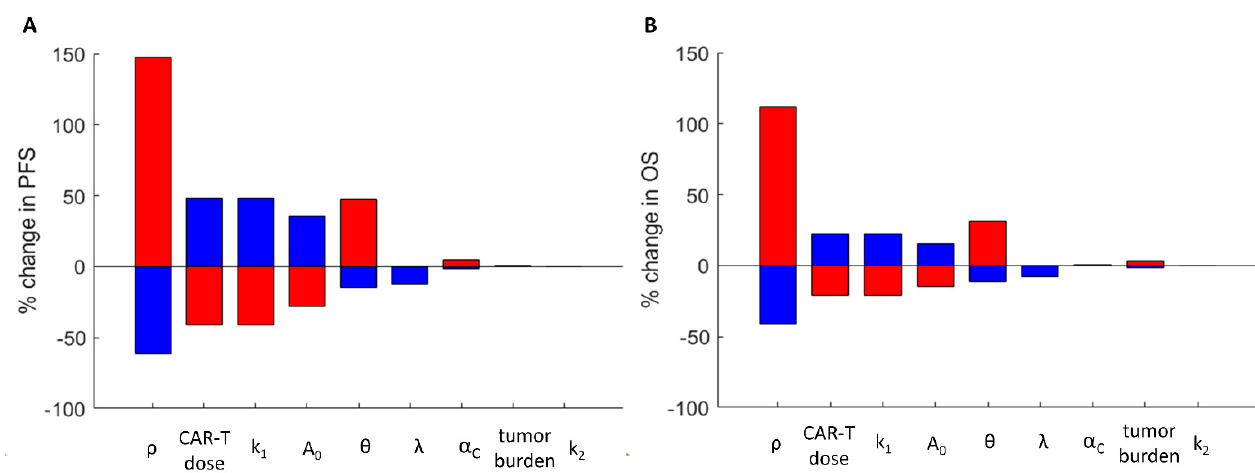
Figure 6. Sensitivity study of the model parameters on the survival outcomes. The change in progression-free survival ( A ) and overall survival ( B ) are shown for a +/ − 50% change in each of the model parameters. Blue indicates a +50% change and red indicates a − 50% change in the parameter. The variations in the tumor proliferation rate have the largest impact on PFS and OS.